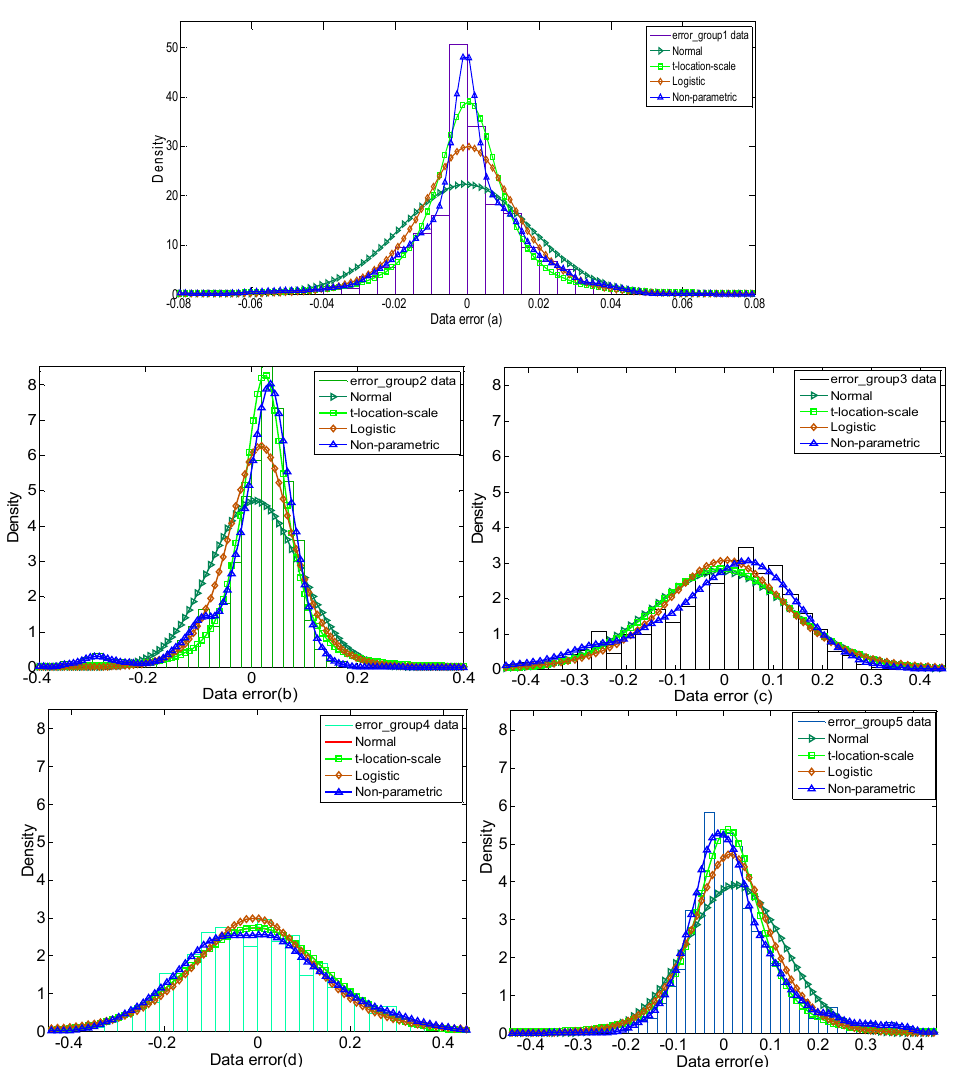
Figure 6. Comparison of error probability density functions in different intervals.